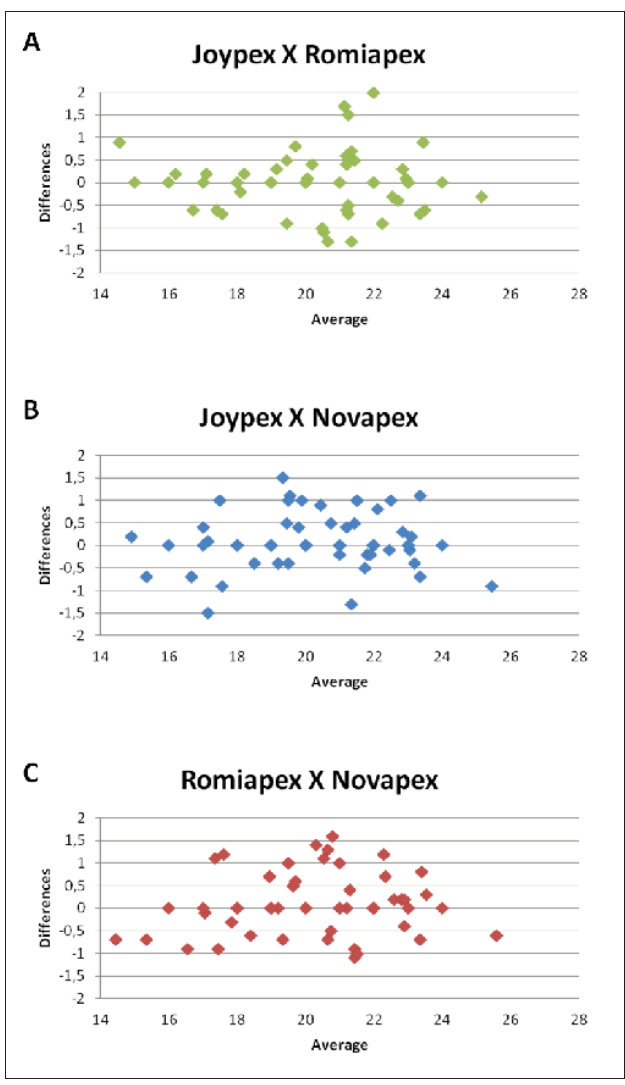
Fig. 1. Bland-Altman plots of differences in WL measurements in all teeth. (a) Joypex X RomiApex (b) Joypex X Novapex (c) RomiApex X Novapex. X-axis shows the mean length (mm) of a certain root canal measured by each pair of electronic apex